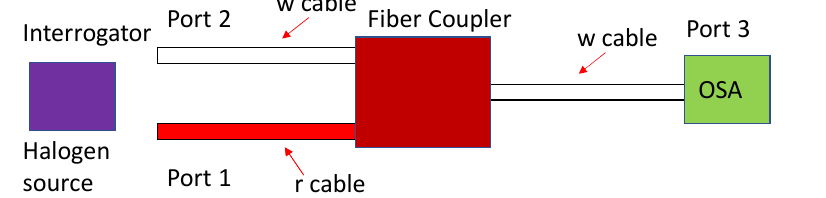
Figure 1. Depiction of the fiber coupler design when the interrogator and halogen light source is connected to either Port 1 or 2 while the optical spectrum analyzer (OSA) detects the transmitted signal.